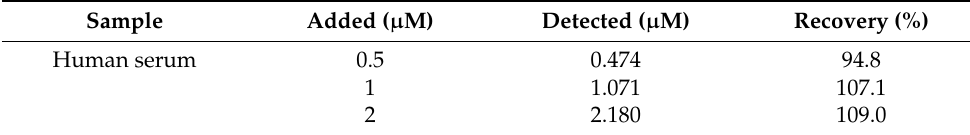
Table 2. Results of aptasensor determination of DOX in spiked human serum